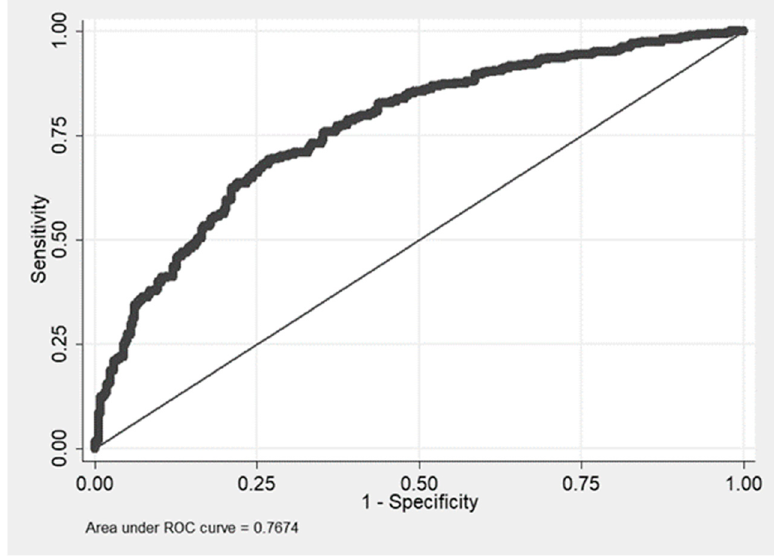
Figure 4. The ROC curve and area under it .